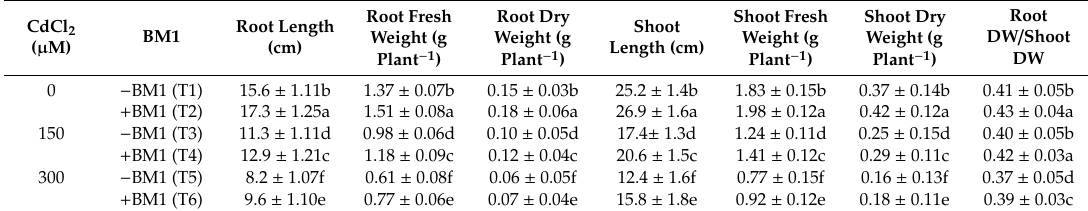
Table 1. Growth and biomass of un-inoculated and inoculated soybean plants with Serratia marcescens BM1 under Cd